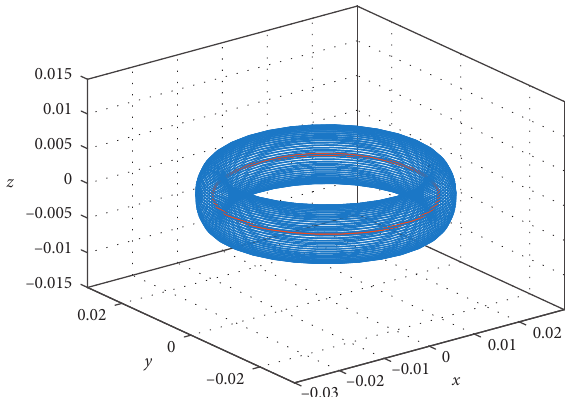
Figure 1: A periodic orbit of system (3) near the origin for a � 10 − 4 surrounded by invariant